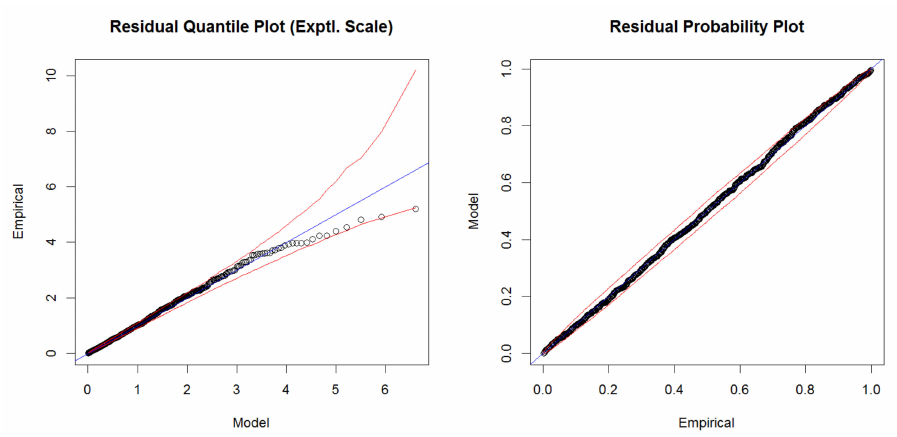
Figure A9. QQ plot ( left ) and PP plot ( right ) when using all data for the estimation for all municipalities ( left ) and for the Mondsee area ( right